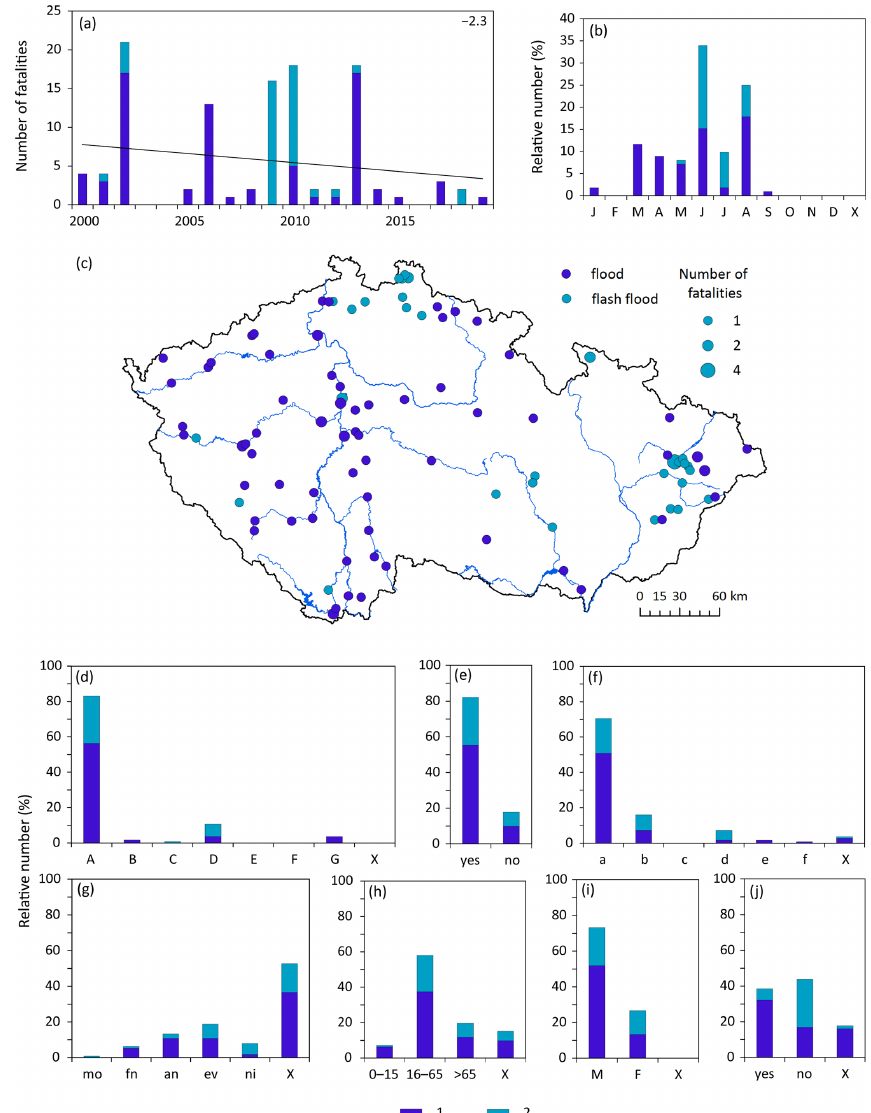
Figure 1. Characteristics of flood fatalities (1 – flood, 2 – flash flood) in the Czech Republic during the 2000–2019 period: (a) fluctuation with linear trend (top right, in fatalities/10 years), (b) annual variation, (c) spatial distribution (two fatalities lack exact locations), (d) cause of death, (e) type of fatality, (f) place of death, (g) part of the day, (h) age, (i) sex, (j) behaviour. Symbols and abbreviations: A – drowning; B – tree or branch fall; C – vehicle accident; D – underlying health reason; E – freezing to death or hypothermia; F – lightning strike; G – other reason; a – river, lake, reservoir, or bank; b – within a building; c – road; d – open space in built-up area; e – open countryside; f – other place; mo – morning; fn – forenoon; an – afternoon; ev – evening; ni – night; M – males; F – females; X –